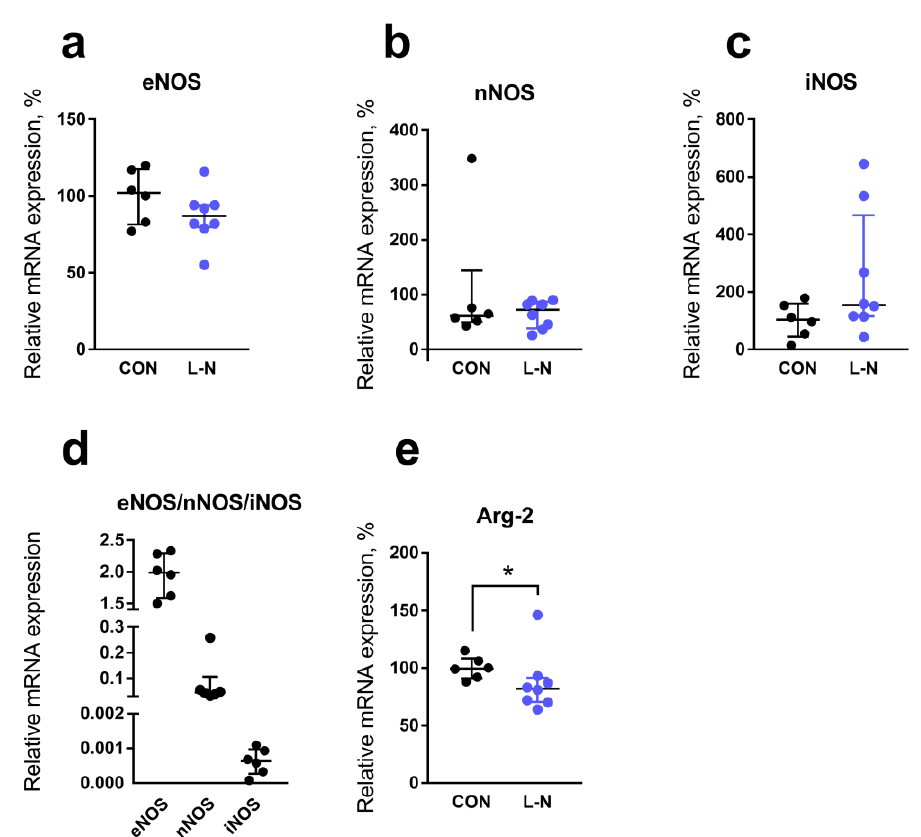
Figure 3. Relative mRNA expression levels of genes related to NO production in the aorta of 1-day- old rat pups. ( a – c , e ) Relative mRNA content of eNOS ( a ), nNOS ( b ), iNOS ( c ) and Arginase-2 ( e ) in aorta of control or L-NAME (L-N) rats. ( d ) Relative mRNA content of eNOS, nNOS, and iNOS in the aorta of control rat pups. The number of tissue samples per group: control—6; L-NAME—8. Data are presented as median and interquartile ranges. * p < 0.05 (Mann-Whitney test).